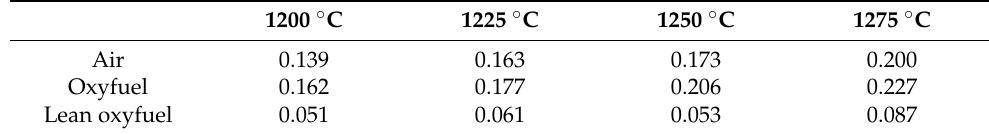
Table 3. End scaling amounts of all samples for TG tests in all atmospheres, in kg/m 2 .